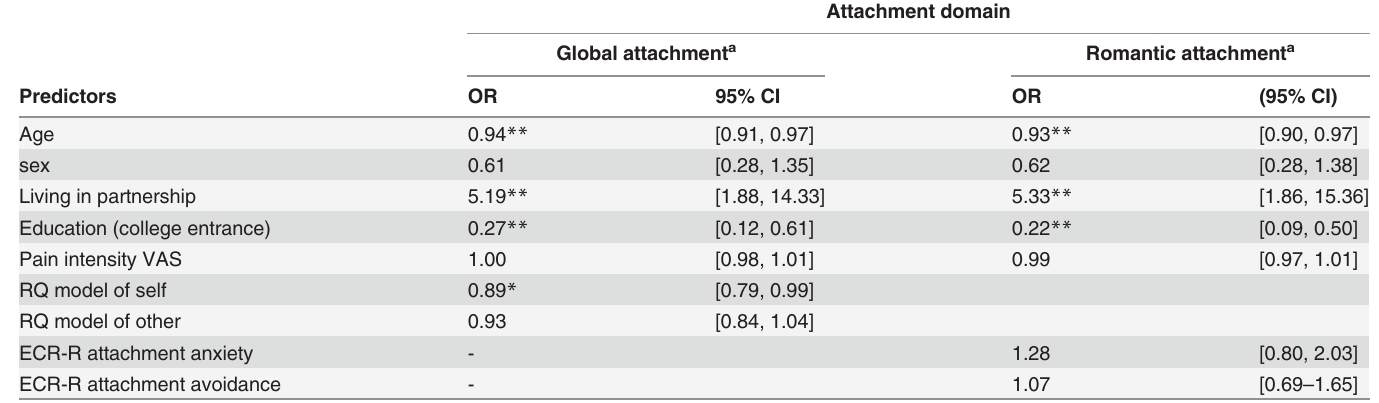
Table 4. Attachment dimensions and pain